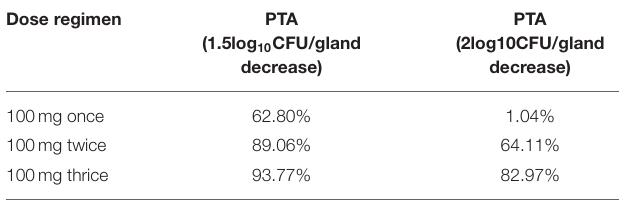
TABLE 6 | The PTA of AUC/MIC for 1.5 or 2log 10 CFU/gland decrease after 100 mg/gland once, twice, and thrice by intramammary administration in cows (PTA was defined as the probability of target attainment that the efficacy probability of clinical 100 mg/gland of rifaximin was obtained by mammary gland injection at different administration